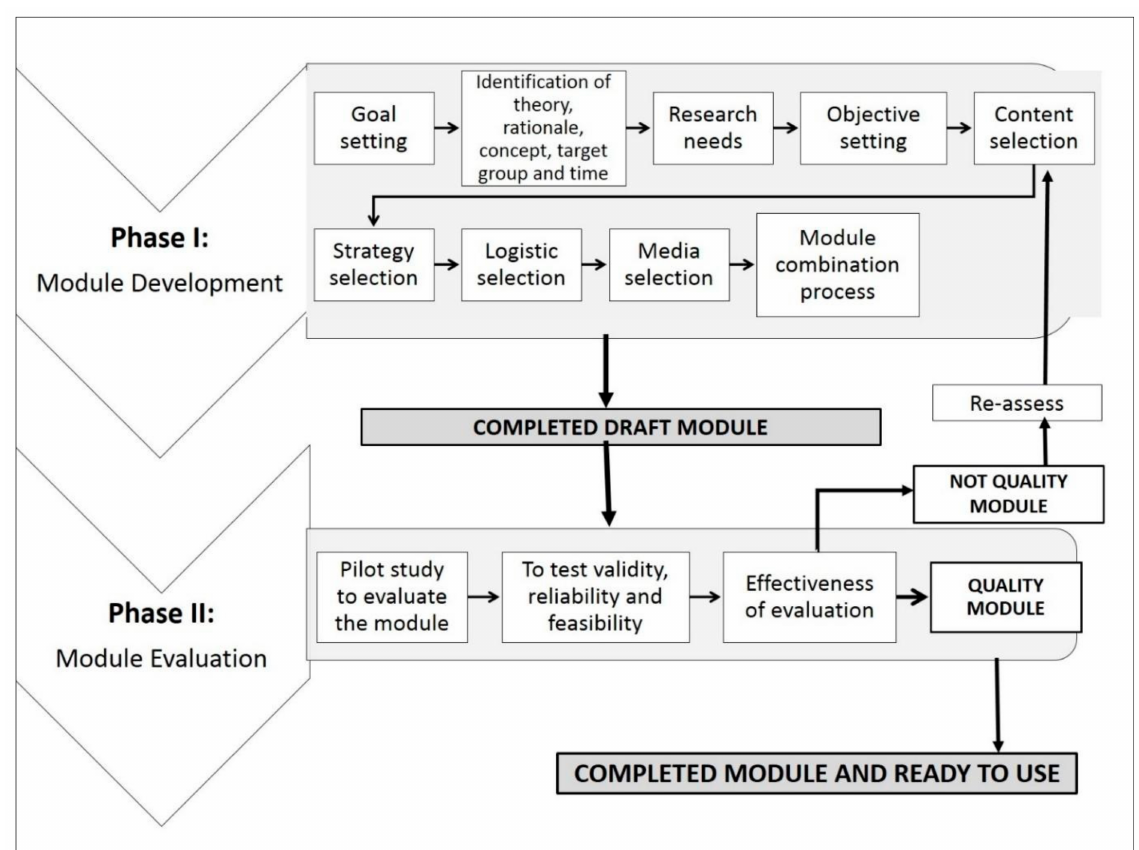
Figure 1. Sidek Module Development